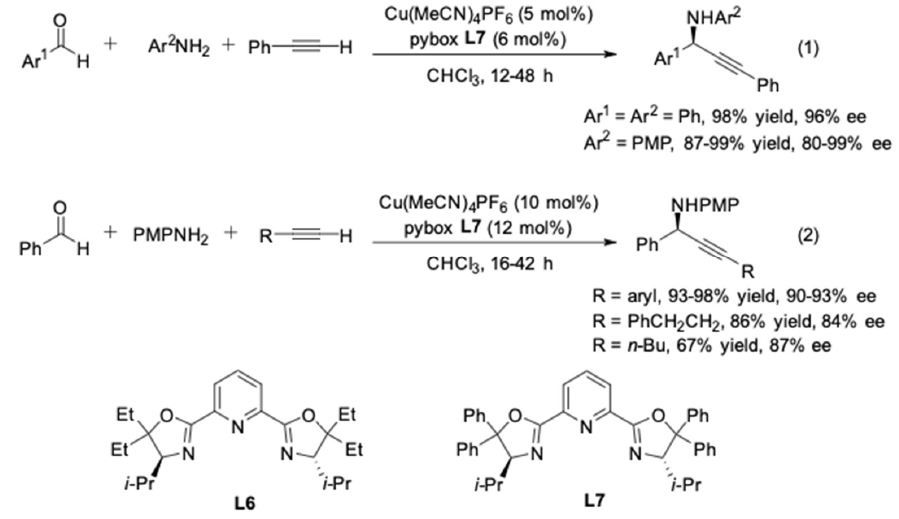
Figure 4. Cu(I)/ i -Pr-pybox-diPh-catalyzed AA 3 -couplings.